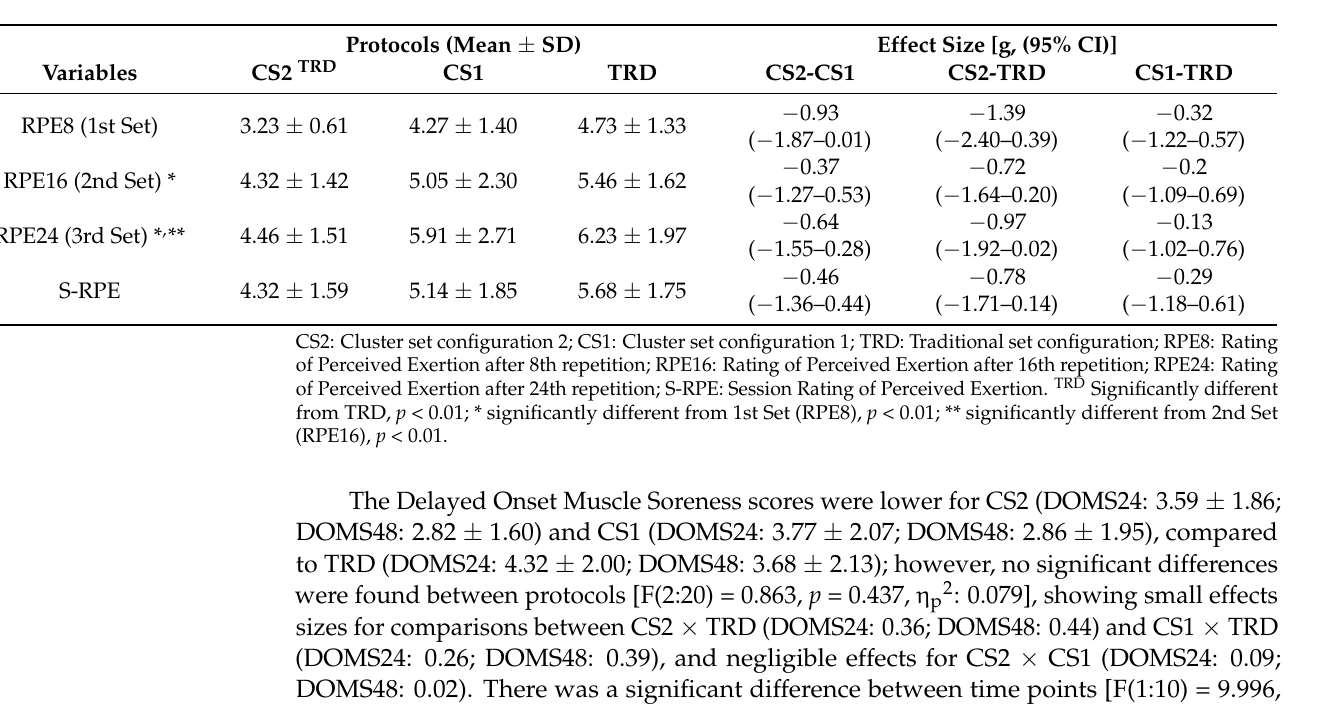
Figure 6. Rating of Perceived Exertion scores in arbitrary units (A.U.) for participants as individual measures (white dots) and overall sample mean (black rectangles) in the sets of each protocol. Table 3. Data (mean ± SD) comparison between protocols for RPE variables and their respective effect sizes.